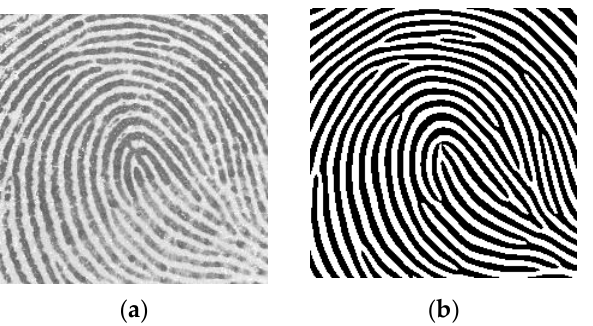
Figure 2. Image enhancement — input image ( a ) and enhanced image ( b ). The input image is taken from FVC2000 database, available online at http://bias.csr.unibo.it/fvc2000/databases.asp, (accessed on 17 February 2021).